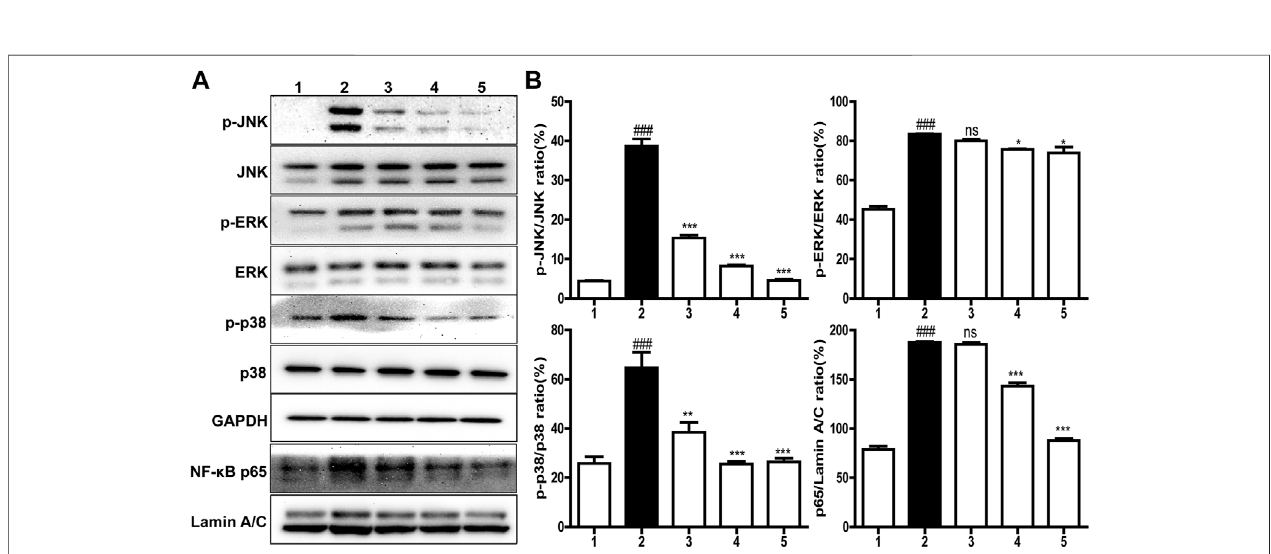
FIGURE 5 | Effects of brevinin-2MP on lipopolysaccharide (LPS)-induced in fl ammatory pathways. (A) Typical western blot images of ERK, JNK, p38, and p65 in RAW 264.7 cells. The cells were incubated with 100 ng/ml LPS and 2.5, 5, and 10 μ M brevinin-2MP for 30 min and then were harvested for western blot examination lines1 – 5arethecontrol,LPS-treatedcells,thecellstreatedby100ng/mlLPSplus2.5,5,and10 μ Mbrevinin-2MP,respectively. (B) Statisticalanalysisofbanddensities in western blot images. The results are shown as ratios of phosphorylated proteins to the corresponding total ones and p65 to Lamin A/C. Band densities were quanti fi ed using Quantity One software (Bio-Rad, Richmond, CA, United States). Data are presented as mean ± SEM ( n (cid:1) 3). p p < 0.05, pp p < 0.01, and ppp p < 0.001 representsigni fi cantdifference incomparison withthecontroltreatedonly withLPS. ### p < 0.001representssigni fi cantdifference withthecontrolwithoutbrevinin-2MP and